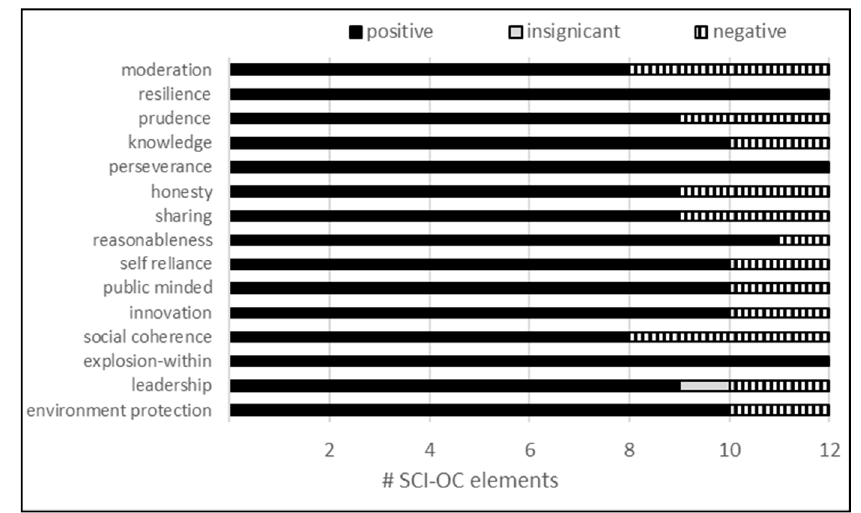
Figure 2. Correlation coefficients between SCI-SEP element and development